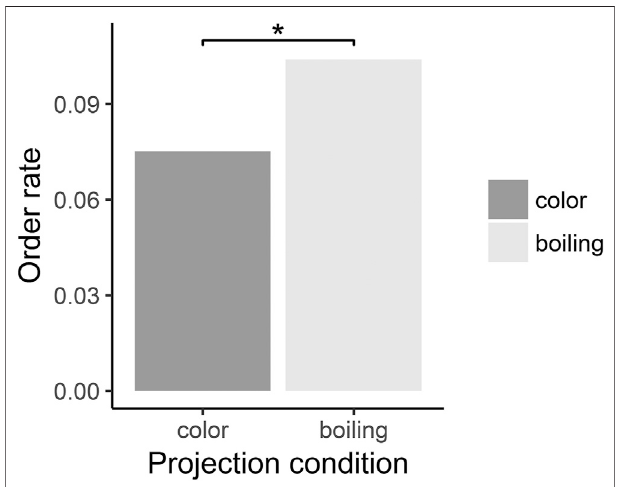
FIGURE 12 | Order rates of the curry. The “ * ” mark represents a signi fi cant difference where p < 0.05.